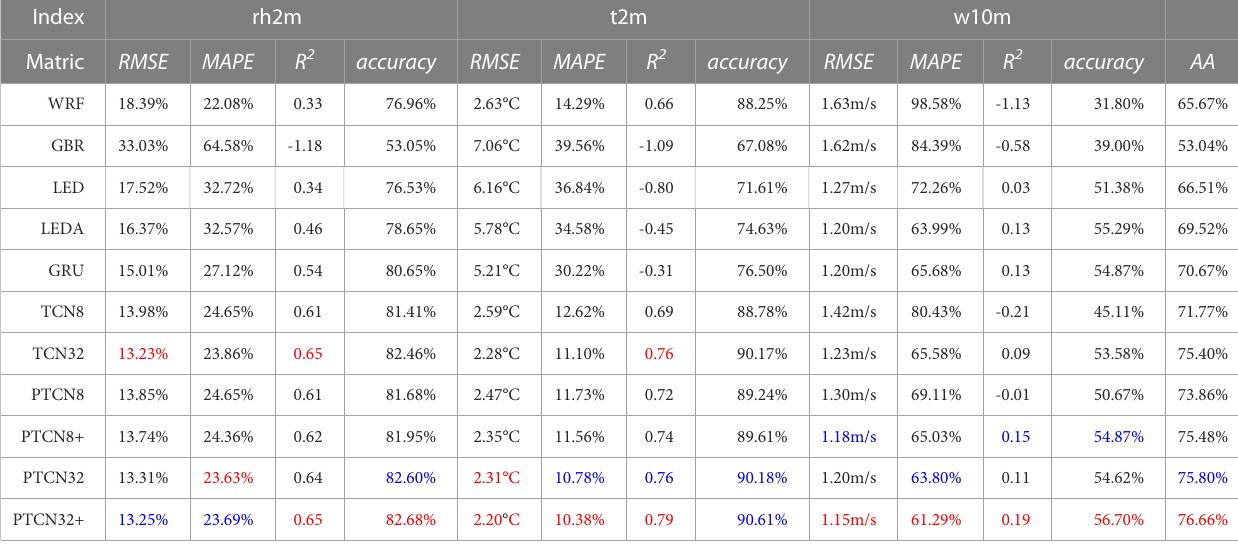
TABLE 4 Comparison of proposed methods with popular sequence prediction methods on WFD2018 aic (2018a). Index rh2m